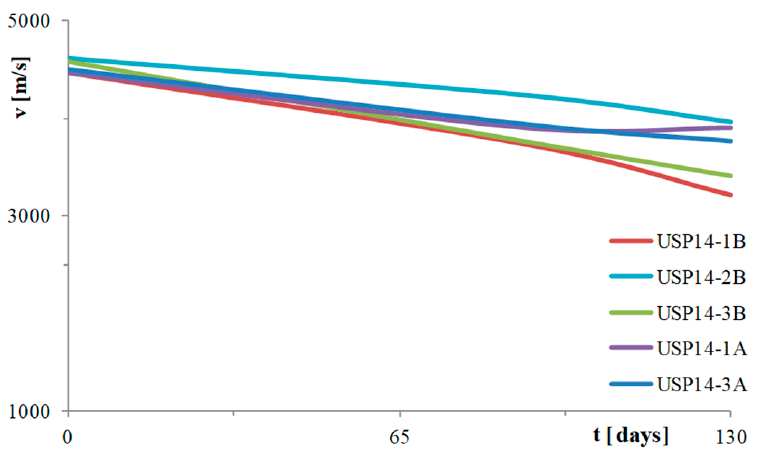
Figure 6. Ultrasound wave rate-time of ageing—rectangular pier.